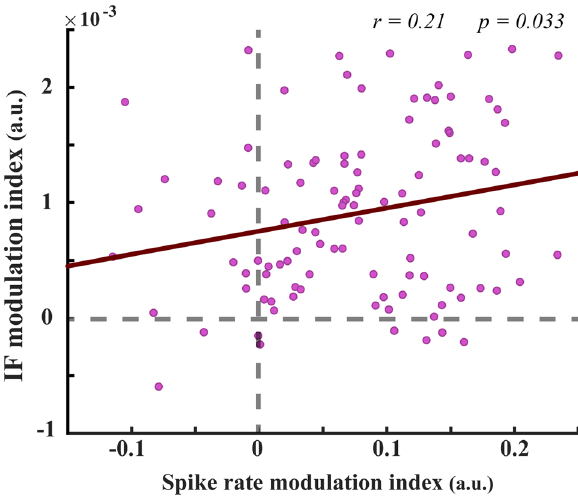
Figure 4. Correlation between neural firing rate variations and variations in theta–alpha IFs of input oscillatory activity. Individual neurons are each represented by a filled circle in the graph. Inset numbers reveal the correlation strength (r, using the Spearman correlation method) and the degree of its significance ( p ) for the shown